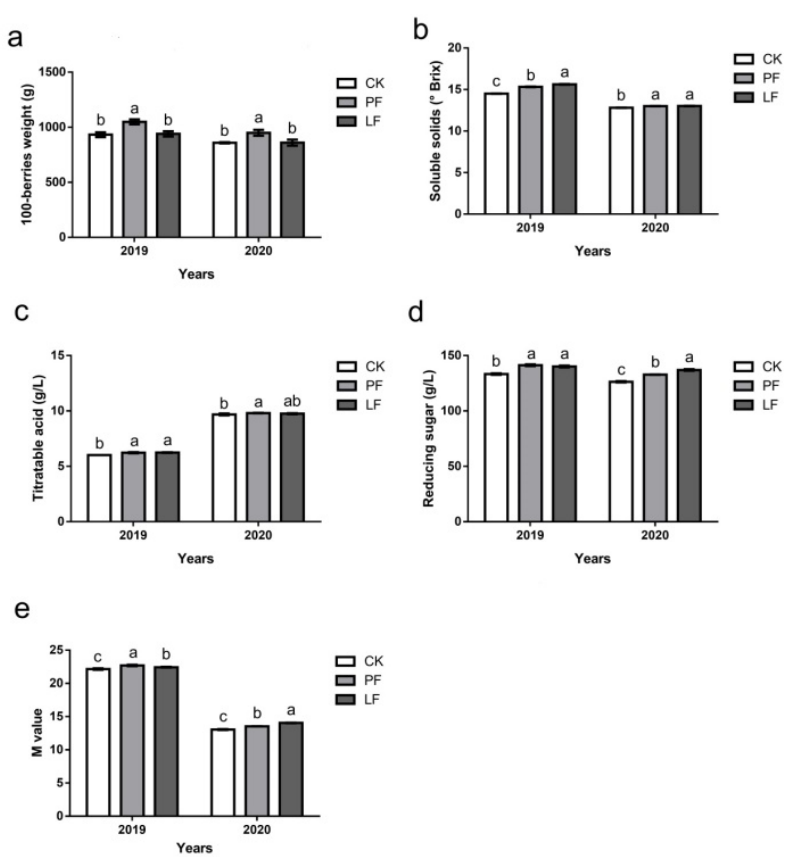
Figure 8. Effects of in-row mulching on the physicochemical indexes of grape berries in 2019 and 2020. ( a ): 100-grain weight; ( b ): Soluble solids (SS); ( c ): Titratable acid (TA); ( d ): Reducing sugar; ( e ): M value. Different letters above the columns indicate significant differences between treatments in Duncan’s multiple comparisons ( p < 0.05) .